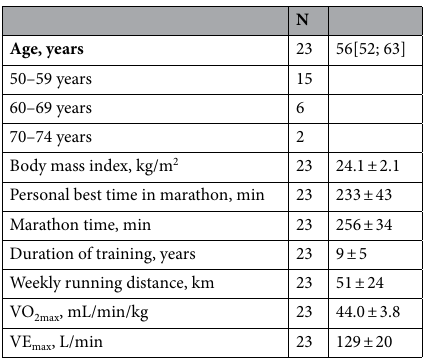
were ensured by visual inspection of frequency histograms. For the parameters measured twice, before and after the competition, pre-race values were tested only. Data are presented as mean ± standard deviation (for continu- ous normally distributed variables), median with lower and upper quartile (for continuous variables that did not follow a normal distribution) or number and percentage (for categorical data). For the parameters measured twice (before and after the race), mean percentage difference ± standard deviation was presented. Paired Student’s t test was used for within-subject comparisons. Pearson’s linear correlation coefficient was used to assess the relations between variables, in particular between the parameters of individual performance (the marathon time and VO 2max ) and the haemodynamic and autonomic parameters (predictors). In order to reduce the number of correlations carried out and avoid redundancy a priori, we decided to analyse the correla- tions for: (1) pre-race values of all haemodynamic and autonomic parameters, (2) pre- versus post-race changes for these parameters only which had changed significantly after the race. Therefore, neither post-race values of all parameters nor the pre- versus post-race changes of the parameters not affected by the competition were included in the correlation analysis. For all haemodynamic and autonomic parameters, a general linear model was used to explore the effect of interaction between pre-race value of a given parameter and pre- versus post-race change in the given parameter ([pre-race × change] interaction) on the dependent variable: the marathon time or VO 2max . To further investigate the nature of the observed significant pre-race × change interactions for a given parameter, the subjects were dichotomized according to the median of the pre-race value of the parameter, and linear correlations between the pre- versus post-race change versus the marathon time or VO 2max were assessed in both groups. Due to the exploratory nature of the study, we decided not to adjust the significance level to account for multiple testing. A value of p < 0.05 was considered statistically significant. In addition to the analysis of correlation, we attempted to compare the marathon time between the subjects with PCheS within the normal range (normal PCheS) and the subjects with peripheral chemoreceptor hypersen- sitivity (high PCheS), according to the cut-off value of V Ins -Hypo commonly used in clinical studies on PCheS in heart failure patients 34–36 . Based on these studies, the value of V Ins -Hypo of − 0.7 L/min/SpO 2 % was used to allocate the subjects into the normal PCheS group (V Ins -Hypo between zero and − 0.7 L/min/SpO 2 %) or high PCheS group (V Ins -Hypo more negative than − 0.7 L/min/SpO 2 %). Last, in order to better visualize the SVR response to breath-holding in slow versus fast finishers, the subjects